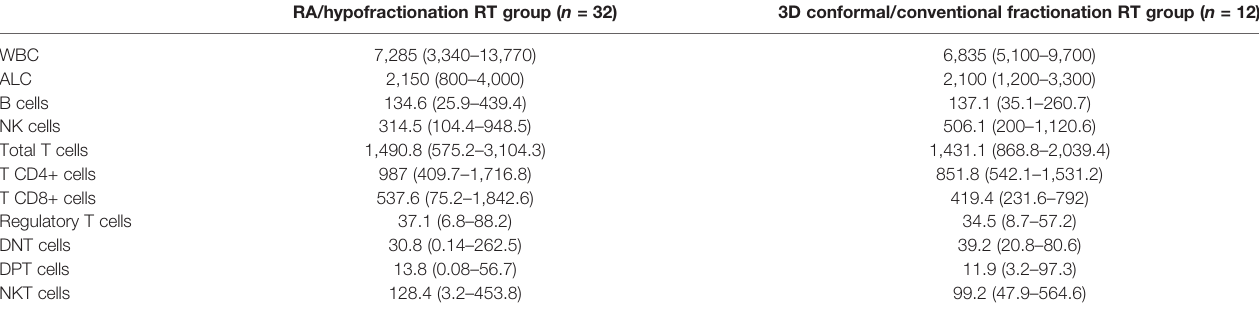
TABLE 2 | Cell populations ’ values at baseline (µl − 1 , median,